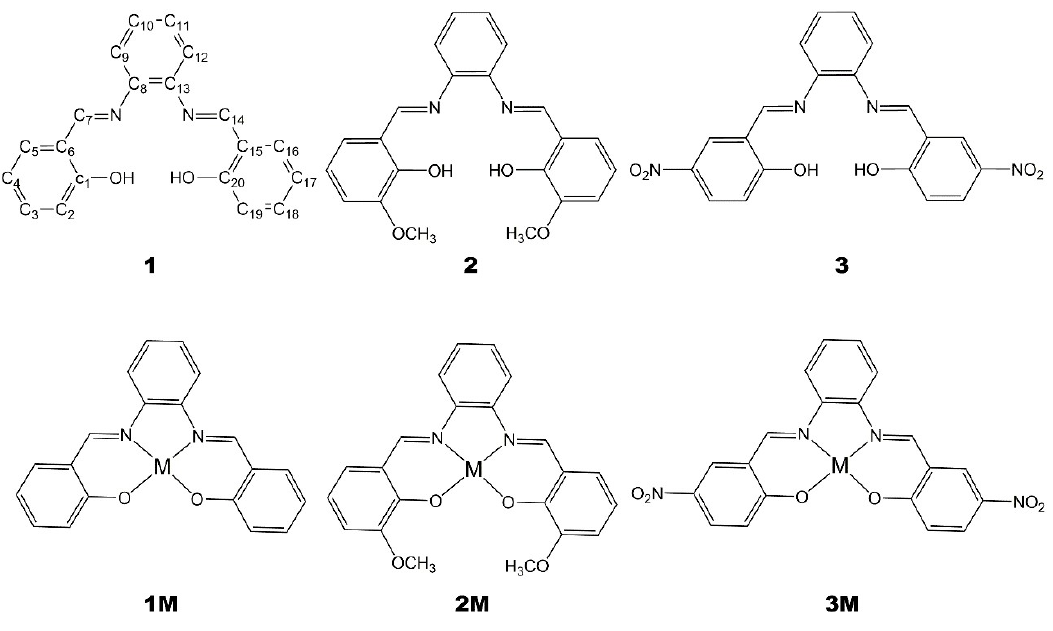
Figure 1. Ligands and corresponding metal complexes under study. Numbering scheme is provided for derivative 1 ( M = Zn, Ni, Pd ) .